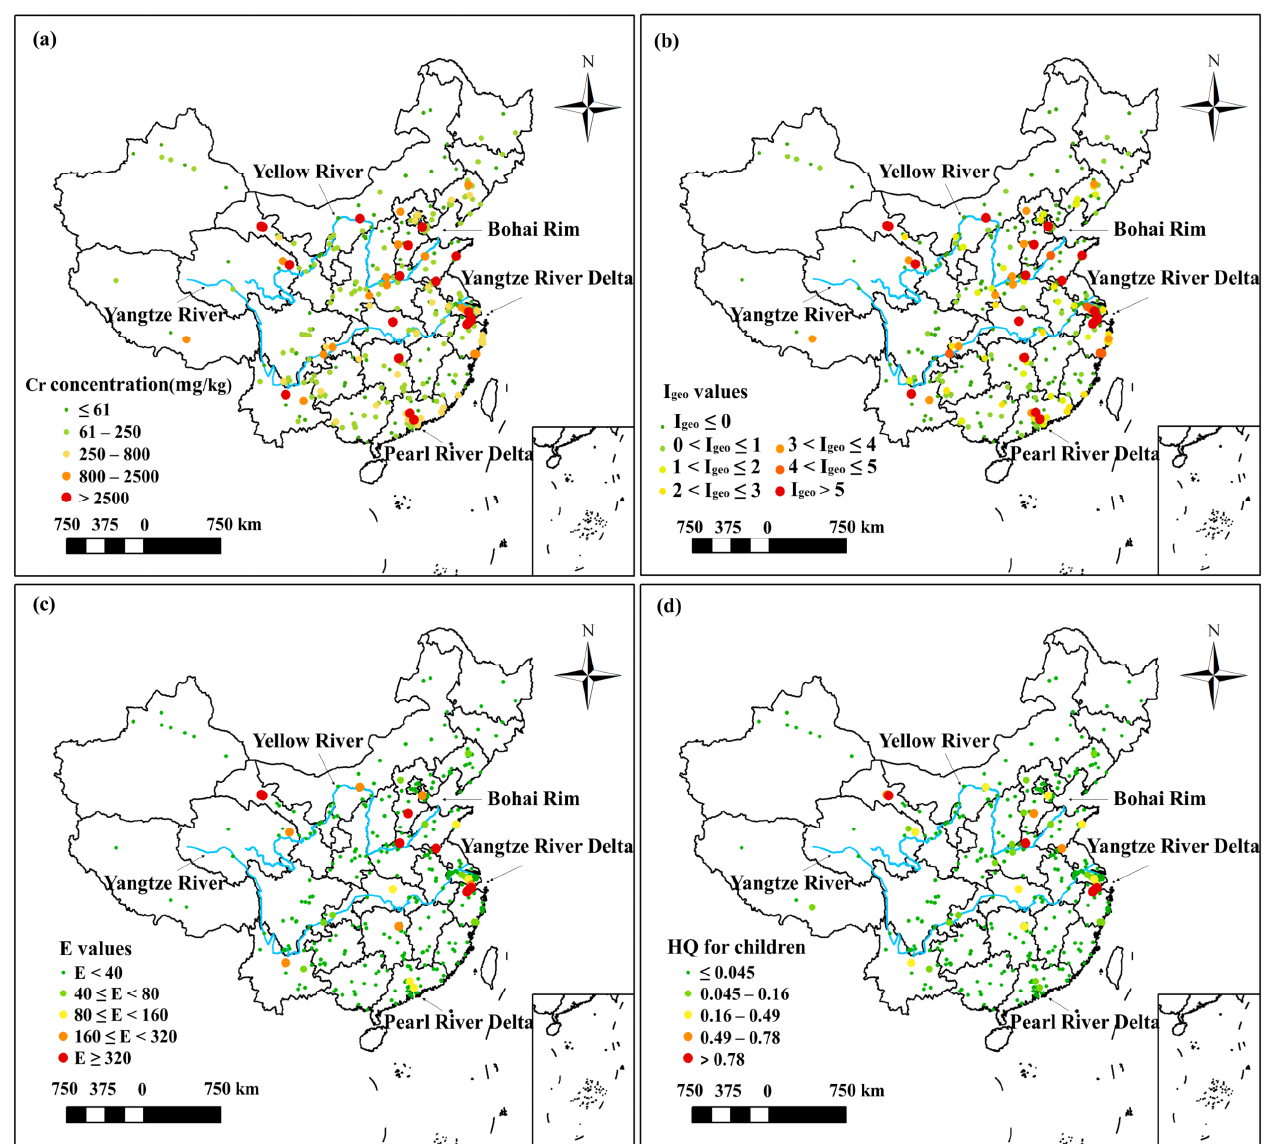
Figure 5. Spatial distribution maps of the ( a ) soil Cr concentrations; ( b ) I geo values; ( c ) E values; and ( d ) HQ values for children.